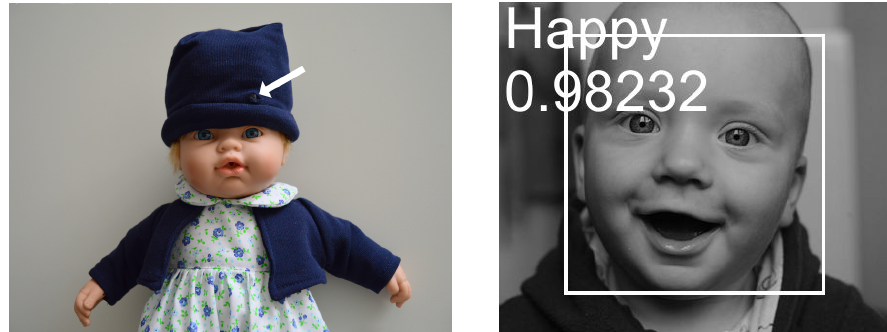
Figure 24. Smart doll with emotion recognition. Left: The camera was in the head, connected through a flex cable to the board and battery inside the body. Right: emotion recognition.